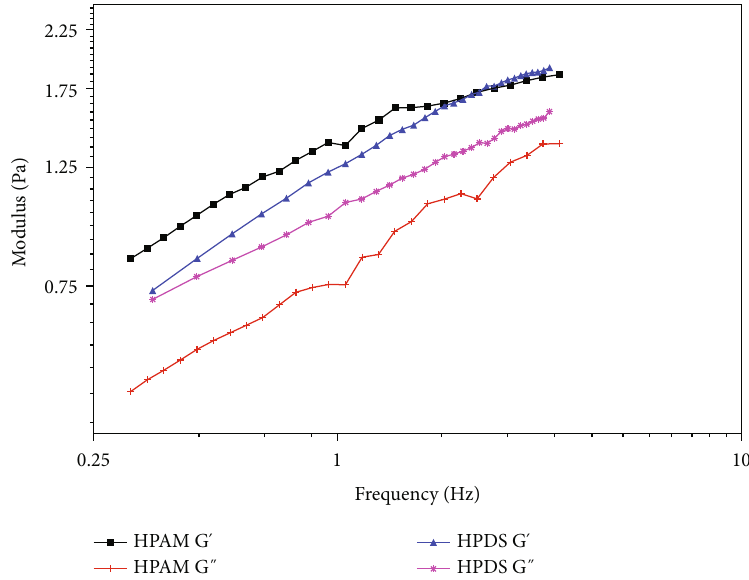
Figure 12: Relationship between modulus and